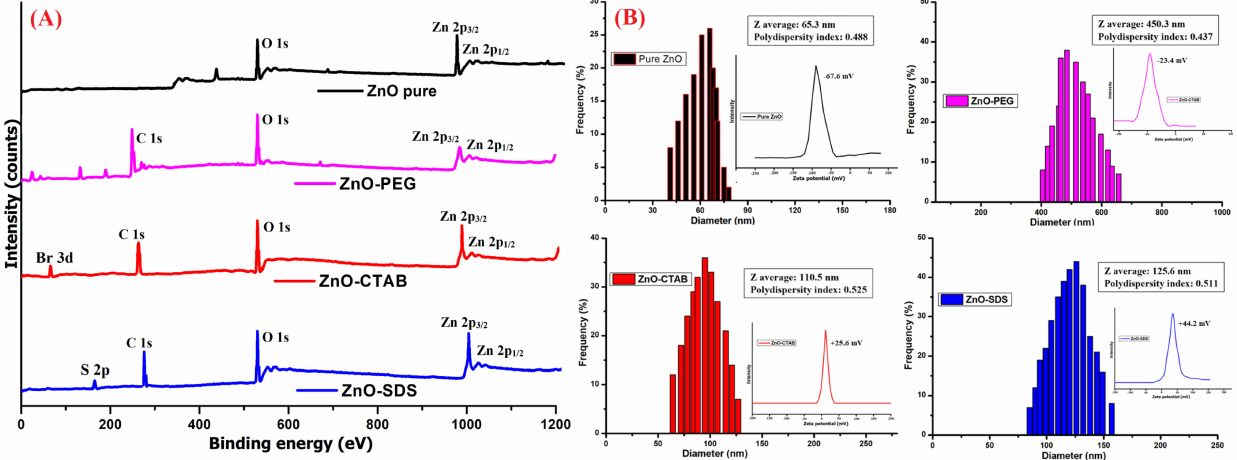
Figure 4. ( A ) XPS and ( B ) DLS analysis of all four ZnO-based composites (inset: Zeta potential studies of the corresponding